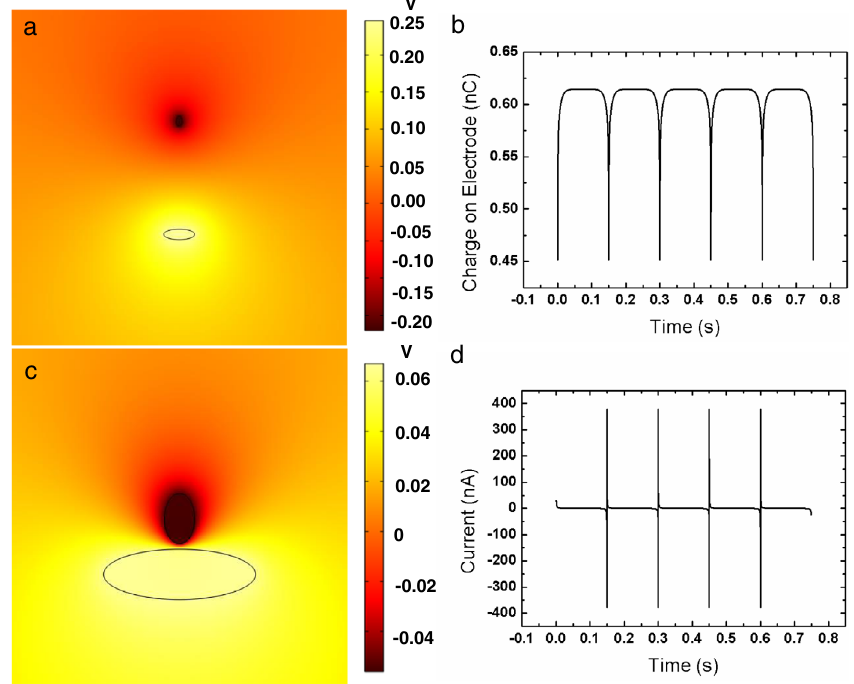
Fig. 6 | Finite element analysis of the L-L TENG. Electric fi eld distribution simulated by fi nite element analysis, from far enough ( a ) to close enough ( c ). b The induced electric current on the electrode over time. d Current waveform obtained by charge waveform